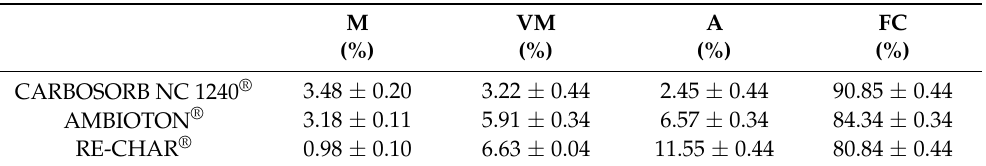
Table 3. Moisture content, volatile matter, ash content, and fixed carbon content of carbonaceous materials, in